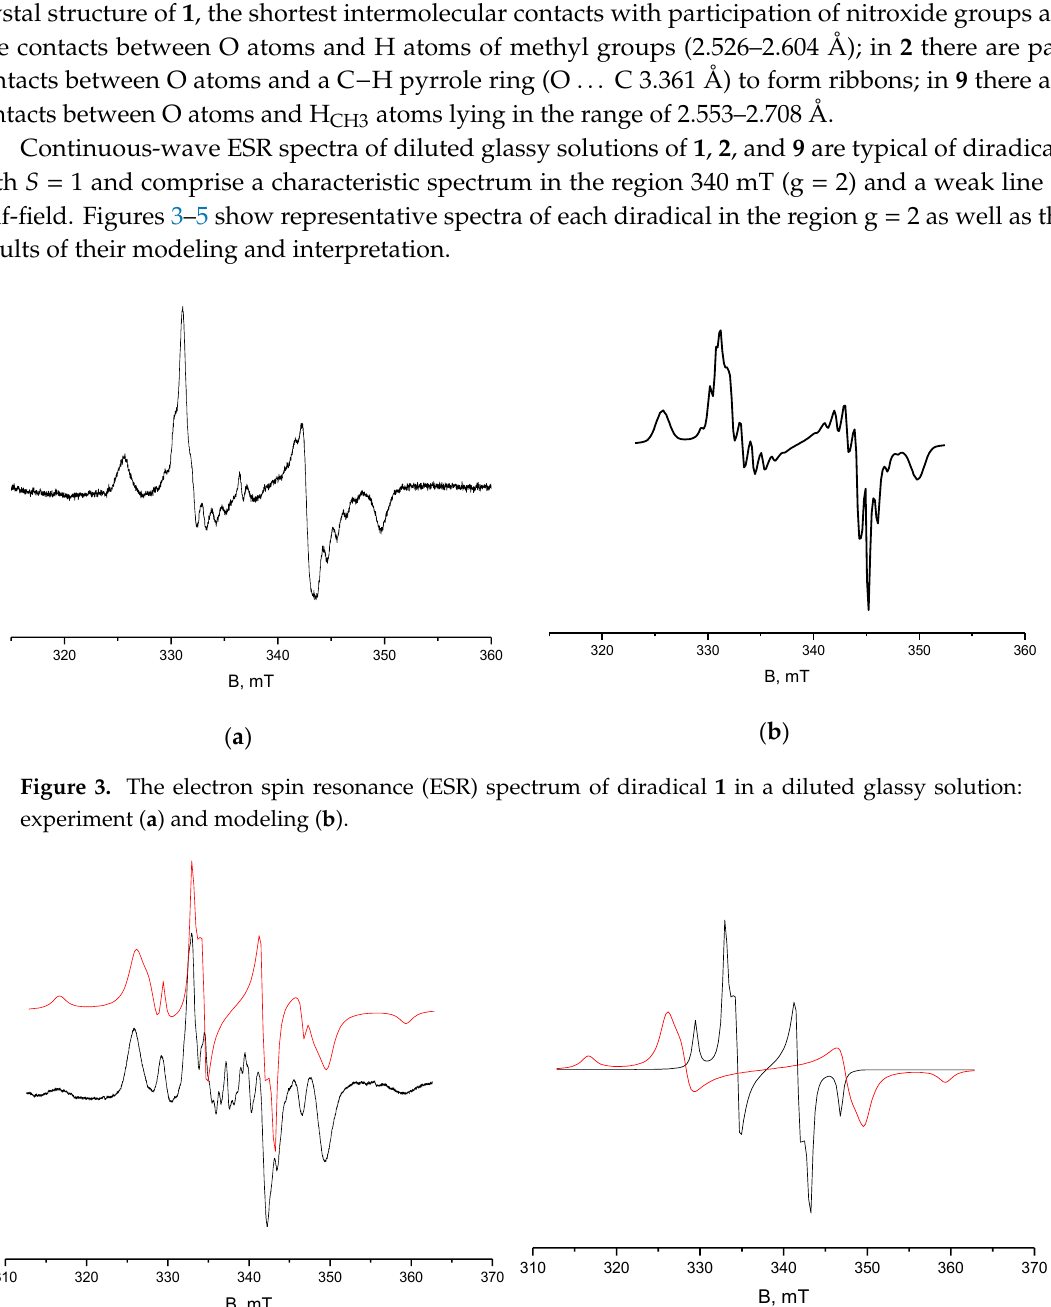
Figure 4. The ESR spectrum of diradical 2 in a diluted glassy solution: experiment and its modeling ( a ), and two components of the model spectrum ( b ).